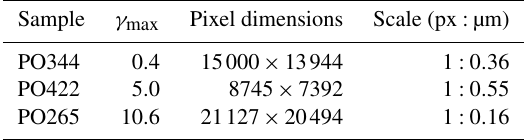
Table A2. Dimensions and resolutions of